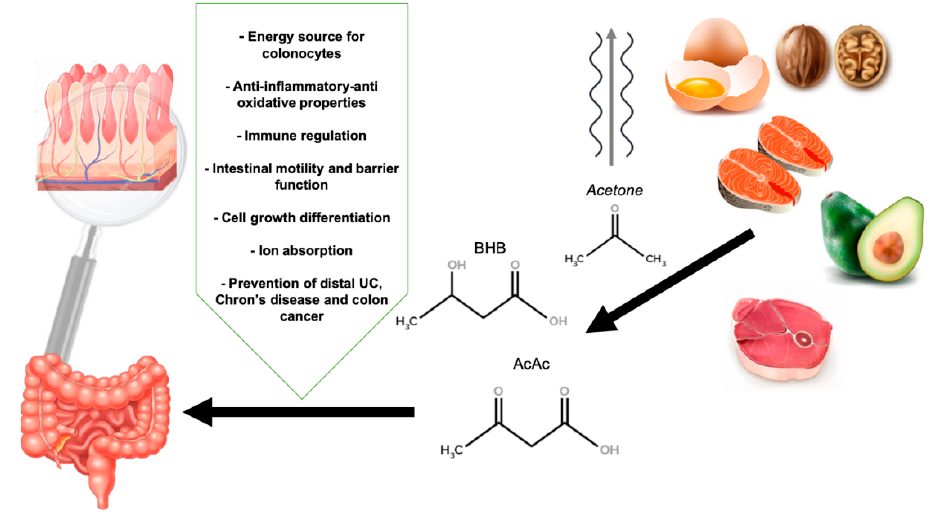
Figure 1. The influence of a very low carbohydrate ketogenic diet and ketone bodies in gut health. BHB: β -hydroxybutyrate, AcAc: